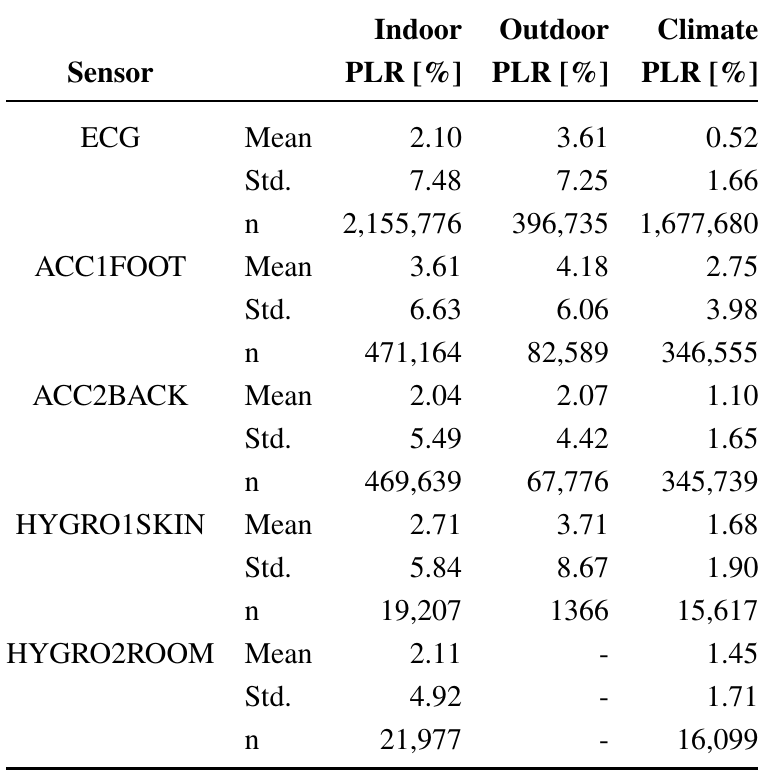
Table 6. The sensors with a constant orientation relative to the master node (ECG, ACC2BACK) have the lowest PLR for each measurement. The highest PLR was measured from the accelerometer that was placed on the left ankle with a mean of 3.51%. Indoor PLR is slightly lower compared with the outdoor results while the climate chamber measurement shows the lowest PLR for all sensors. This might be due to the change of the measurement environment: the treadmill was located in a temporary lab space in a container. Instead of concrete, the walls were made of steel and therefore increasing the reflection of the radio waves compared with the outdoor measurement, thus improving the PLR. Furthermore, the climate room measurement was also performed in an isolated metal chamber. Additionally, the participants did not move during the measurement. Table 6. PLR rates for the on-body measurements with IPANEMA generation 2.5 nodes. Please note that the ambient hygro-/thermometer was not used during the outdoor measurements. The number of indoor transmitted packets is larger because more indoor measurements were performed than climate chamber and outdoor